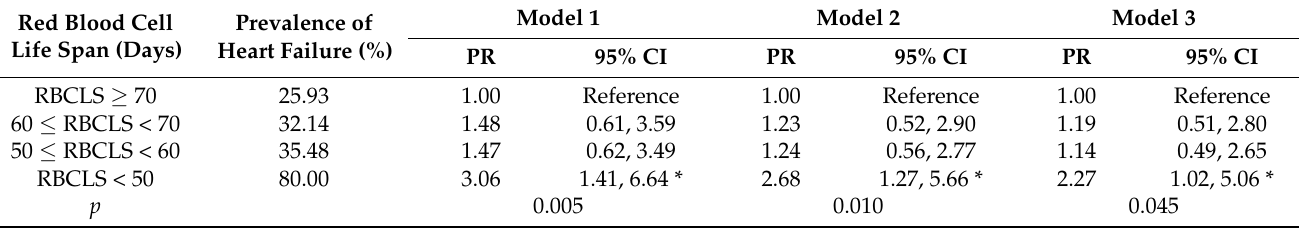
therapy. Model 3 adjusted for serum creatinine, hemoglobin, CRP, RDW, and albumin. * p < 0.05 vs. RBCLS ≥ 70 d group. p for trend >